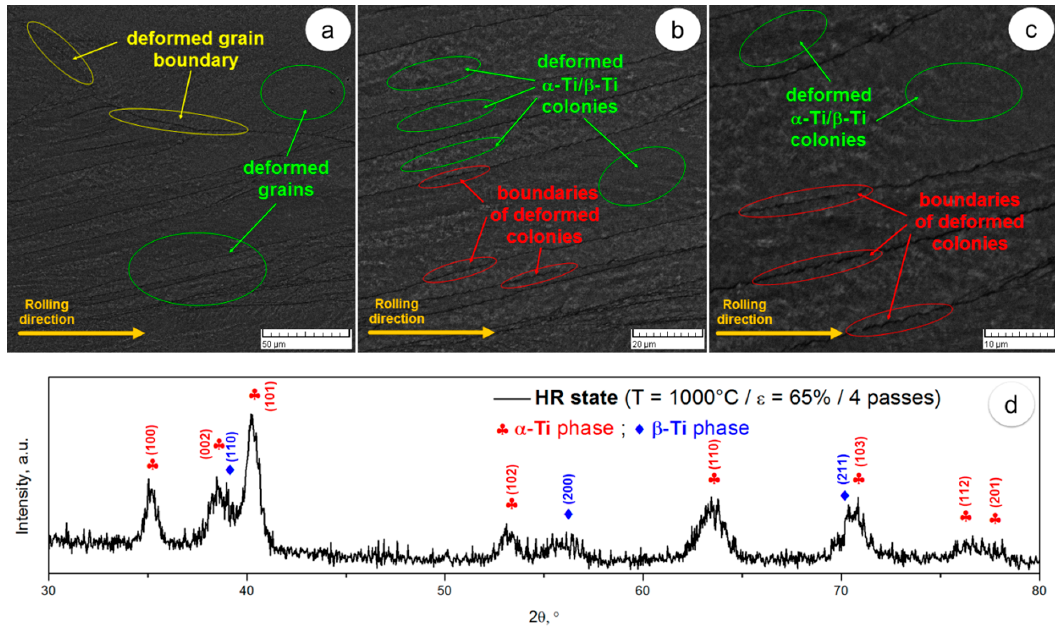
Figure 5. ( a – c ) SEM-BSE images of hot-deformed (HR) state in di ff erent magnifications; ( d ) XRD spectra Figure 5. ( a–c ) SEM-BSE images of hot-deformed (HR) state in different magnifications; ( d ) XRD of HR spectra of HR state.